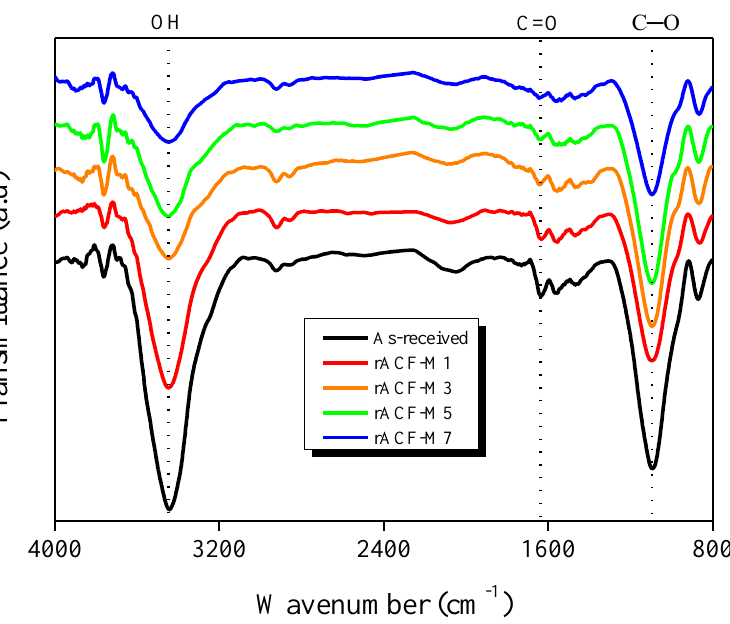
Figure 1. Fourier transform infrared spectroscopy spectra of activated carbon fibers according to the microwave heating time.